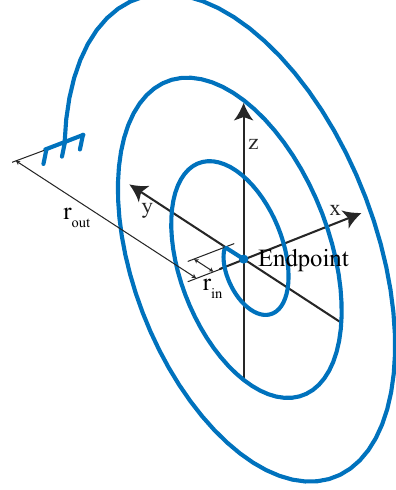
Figure 1. Basic shape of a spiral turning inward from radius r out to r in in three full revolutions. The curve defining the spiral is defined in the yz -plane. The inner end of the spiral is rigidly connected to the endpoint , considered the end-effector of the